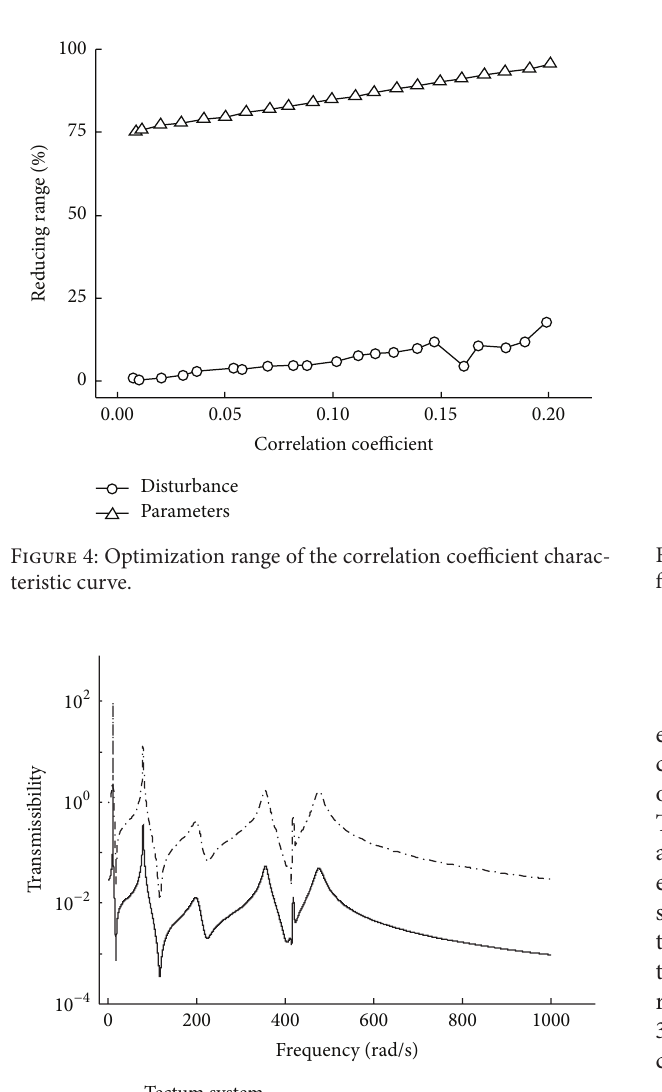
decreases by 75.71% when the correlation coefficient is 0.0085.